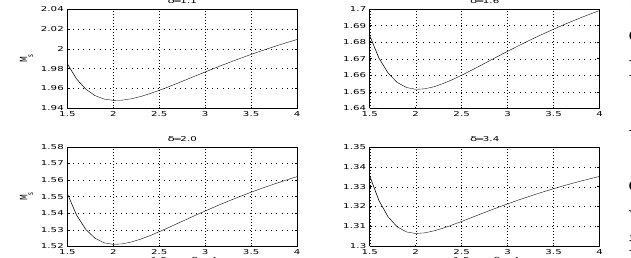
Figure 1: PI control of integrating plus delay pro- cess, h p ( s ) = k e − τs . PI-controller h c ( s ) = s with settings k = 1 and τ = 1. K p 1+ T i s T i s Sensitivity index M s as a function of vary- ing method product parameter 1 . 5 ≤ ¯ c ≤ 4 . and varying δ . ¯ c = 2 . 0 is optimal in the sense that M s is minimized.